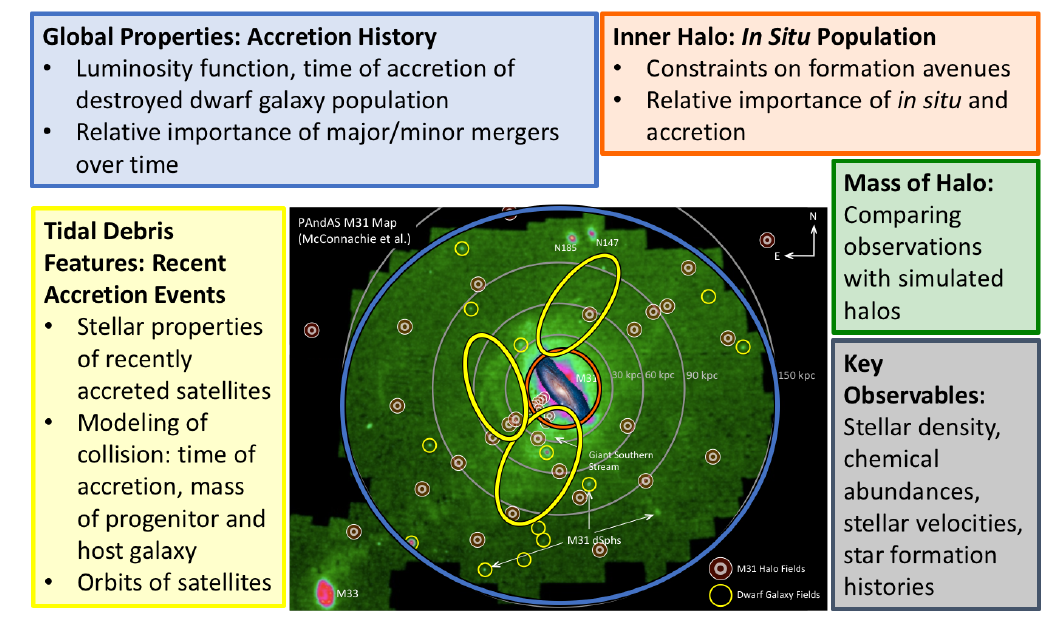
Figure 1. A summary of what can be learned from observations of stellar halos. The underlying figure (Figure 2 of [9]) portrays the stellar surface density of M31’s stellar halo, and was generated from resolved star counts derived from images obtained with the MegaCam instrument on the Canada-France-Hawaii Telescope by the PAndAS survey